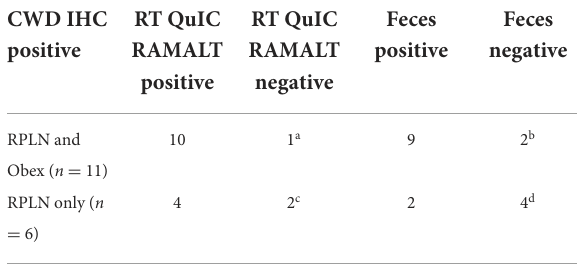
TABLE 2 Rectal mucosa-associated lymphoid tissue (RAMALT) and feces RT-QuIC reactivity in deer showing prion protein detection